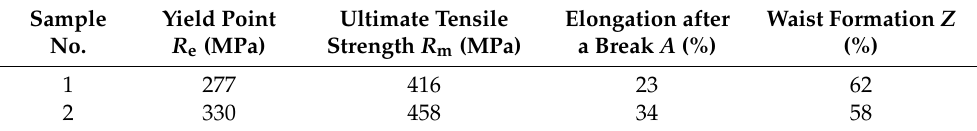
Table 6. Results of the static tensile tests of samples from the handy-size bulk carrier 30210 DWT. Sample